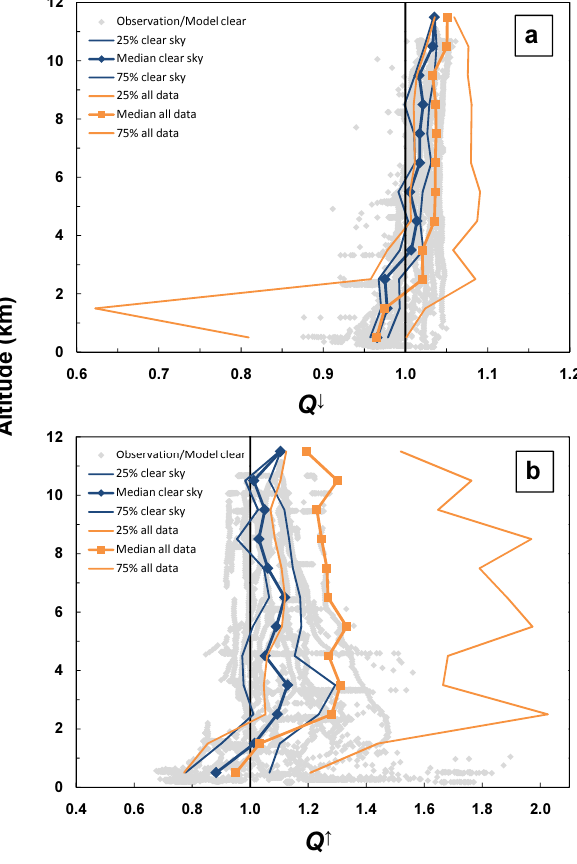
model actinic fluxes, for cloud-free (blue) and all (orange) condi- tions. Panel (a) is for down-welling radiation, panel (b) for up- welling. Central line (with markers) gives median values while thinner lines show the quartiles. Grey points show individual data points for cloud-free